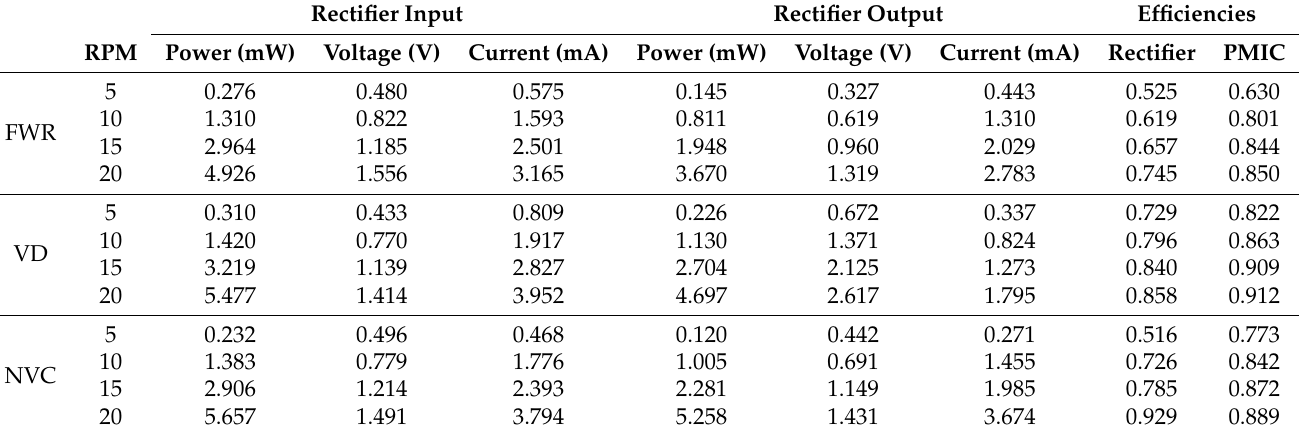
Figure 14. Optimized PCE and PEE values at different rotational speeds for ( a ) PCE-optimized tuning capacitance and ( b ) PEE-optimized tuning capacitance. Table 4. Input and output conditions of the PEE-optimized interface circuits based on FWR, VD, and